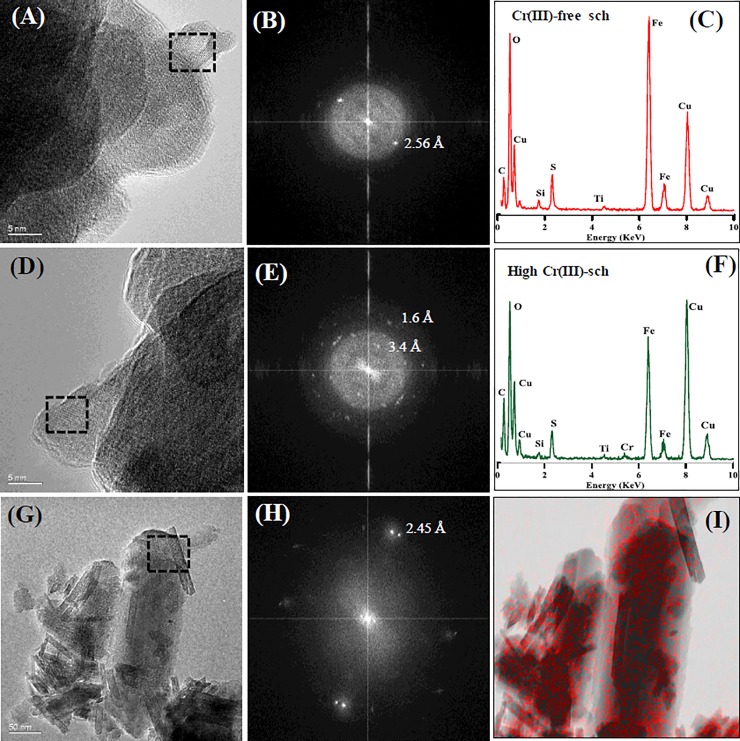
HRTEM micrographs.(A) Cr(III)-free schwertmannite; (B) FFT pattern of area enclosed by dashed-line in (A); (C) TEM-EDX spectrum of zero Cr(III)-schwertmannite; (D) high Cr(III)-schwertmannite; (E) FFT pattern of the area enclosed by dashed-line in (D); (F) EDX spectrum of high Cr(III)-schwertmannite; (G) high Cr(III)-schwertmannite sample that was treated with 10 mM Fe(II) after 14 days, (H) corresponding FFT pattern of the area enclosed by dashed line in (G) and (I) elemental mapping of sample shows Cr distribution.